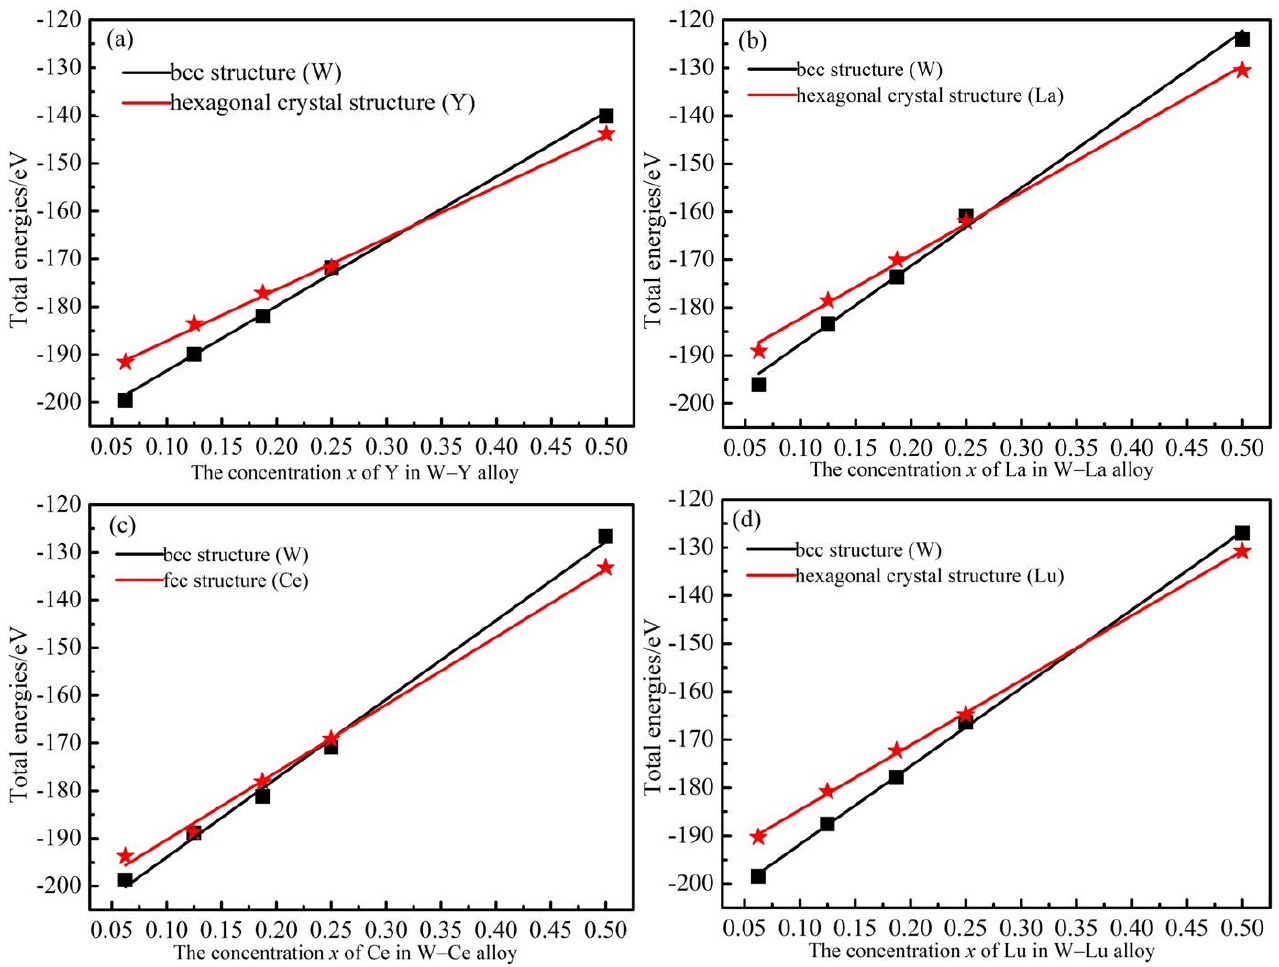
Figure 3. The total energy of the system as a function of different ingredients in bcc W and M structures. ( a – d ) represent W-Y, W-La, W-Ce and W-Lu systems, respectively.